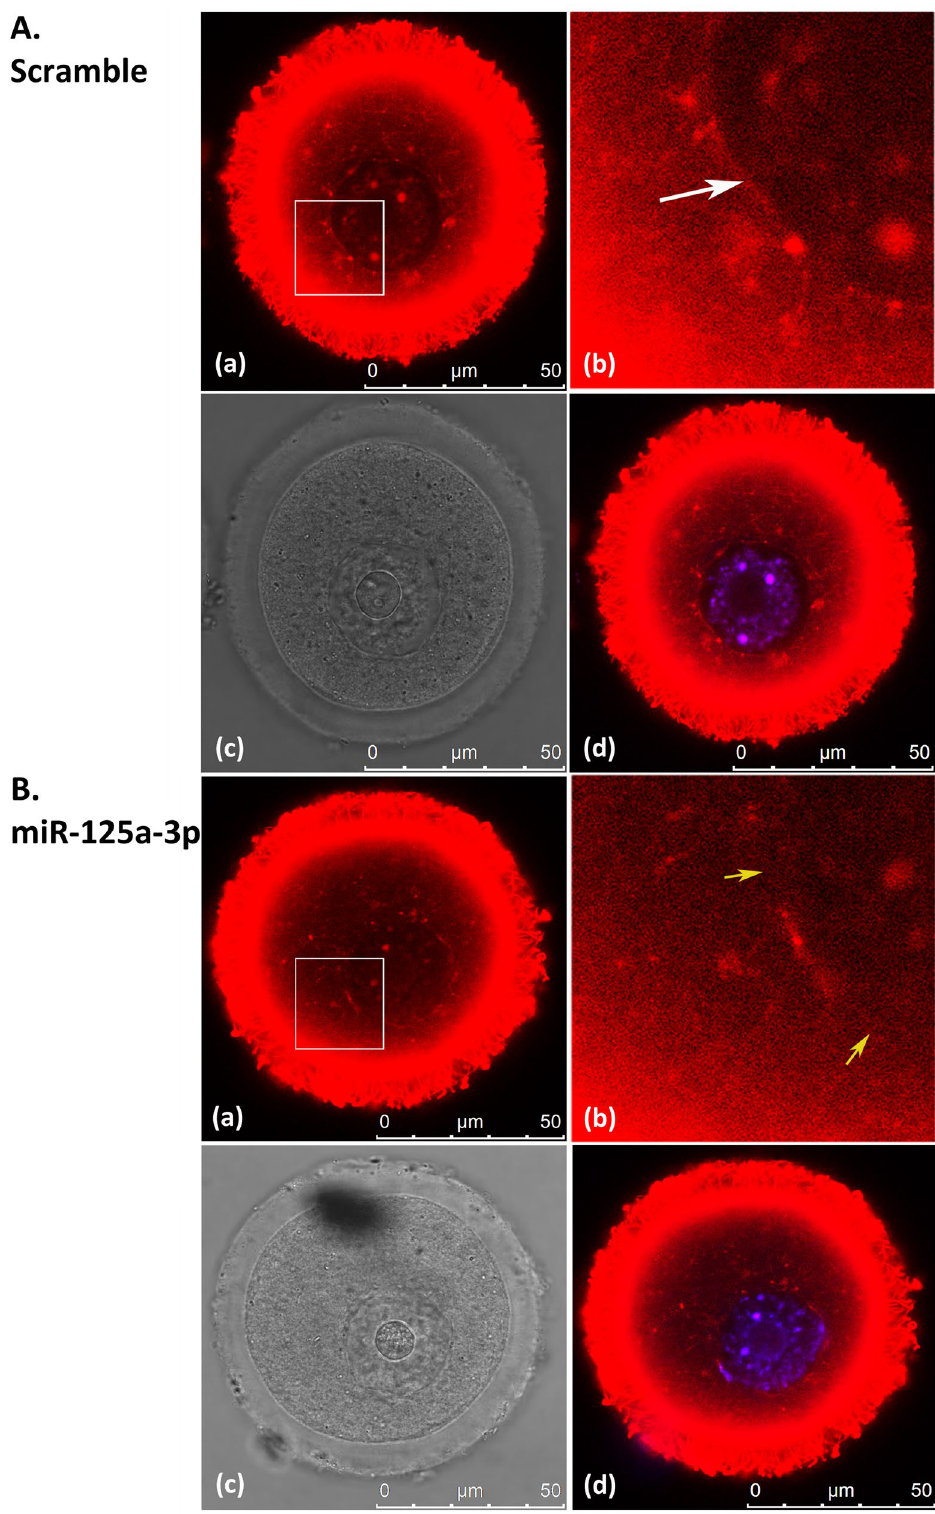
Figure 4. Over-expression of miR-125a-3p hampers the organization of the nuclear actin rim. GV oocytes were microinjected with either scramble-miR ( A ) or miR-125a-3p mimic ( B ). Oocytes were incubated for 4 hours at 37 °C in the presence of 1 µ M milrinone prior to fixation performed as described in ‘Experimental Procedures’. Actin filaments were stained with Tritc-Phalloidin (red) diluted in PBS containing 0.1% Triton X-100 and 3% BSA. DNA was stained with Hoecst (blue). (a) Tritc-Phalloidin; (b) Enlargement of the area marked in (a); (c) Bright field; (d) Merge of Tritc-Phalloidin and Hoecst. White arrow points at the actin rim of a scramble- microinjected oocyte. Yellow arrows point at gaps within the actin rim of a miR-125a-3p-microinjected